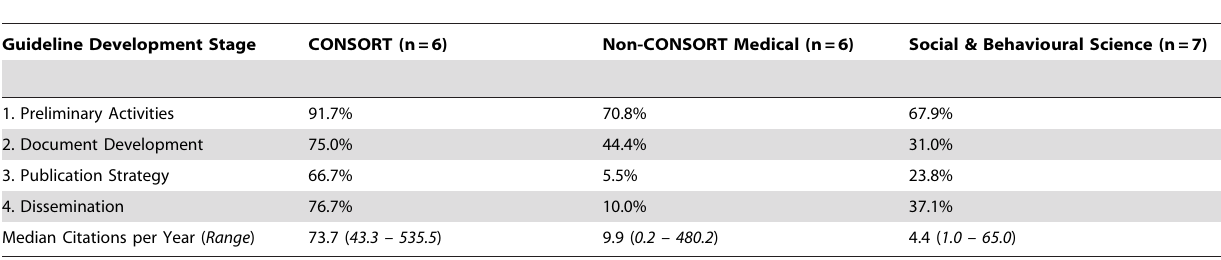
Table 2. Average percentage of recommended techniques for guideline development by document